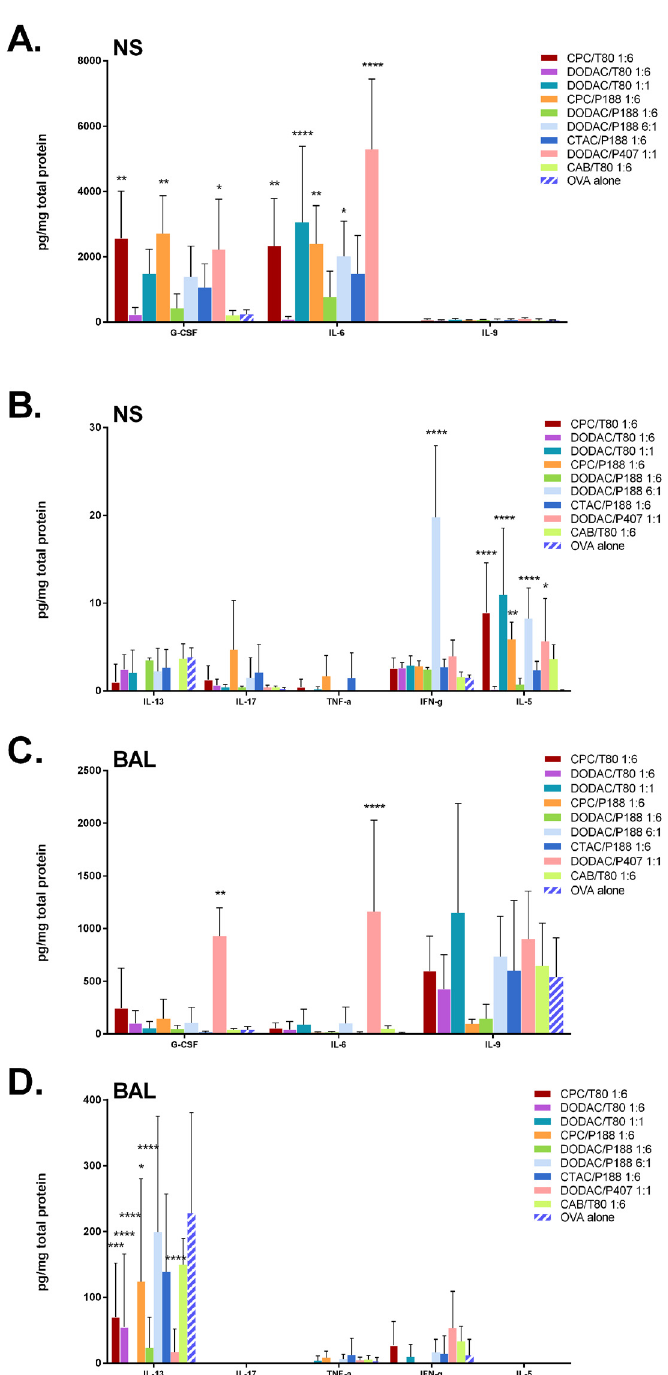
Fig 9. Acute phase cytokine profiles of C57/Bl6 mice. Cytokine levels measured 24 h after immunization with 20% NE with 20 mg/mL of OVA in 15 μ L (7.5 μ L/nare) (n = 4 per group). Levels of G-CSF, IFN- γ , IL-5, IL- 6, IL-9, IL-13, IL-17, and TNF- α were measured by Milliplex and normalized to total protein concentration for (A, B) nasal septum homogenate (NS), and (C, D) bronchial alveolar lavages (BAL). ( * p < 0.05, ** p < 0.01, *** p < 0.001, **** p < 0.0001 as compared to OVA alone using 2-way ANOVA with Dunnett ’ s multiple comparison